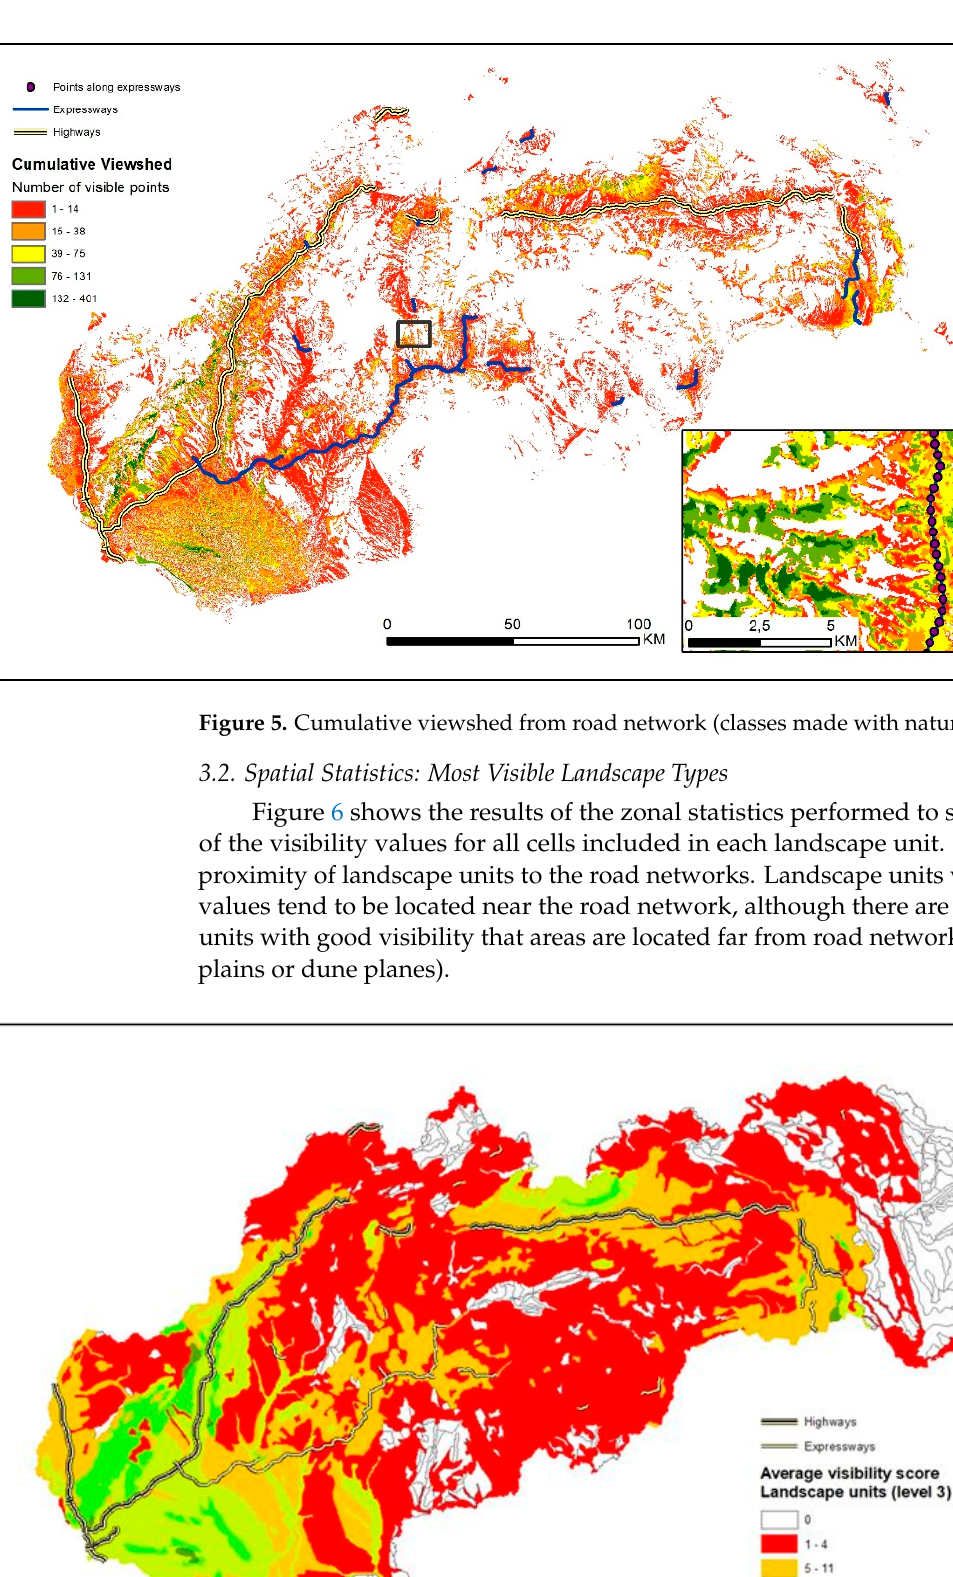
Figure 6. Visibility scores summarized per landscape unit (level 3). Table 2 reports the primary statistics of the number of visible points summarized for the different landscape types, namely for levels 1 (basic types), 2 (characteristics types),